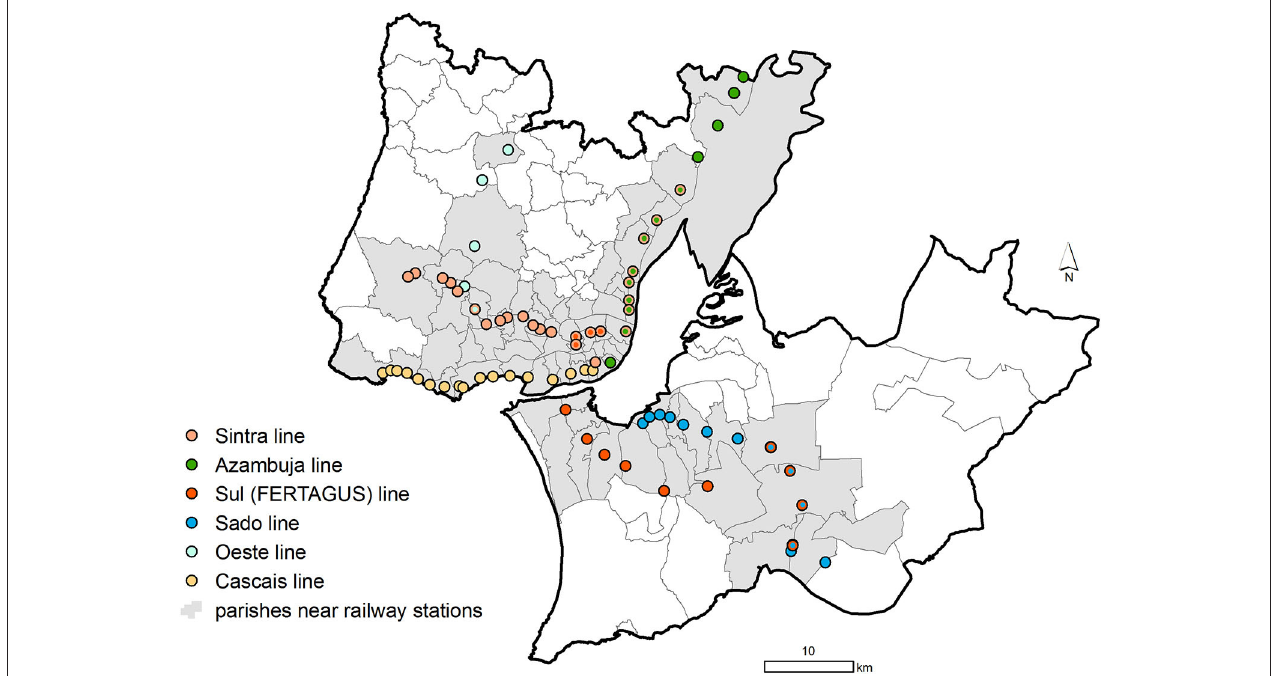
FIGURE 1 | Location of the railway stations from the Lisbon Metropolitan Area in 5 July 2020.